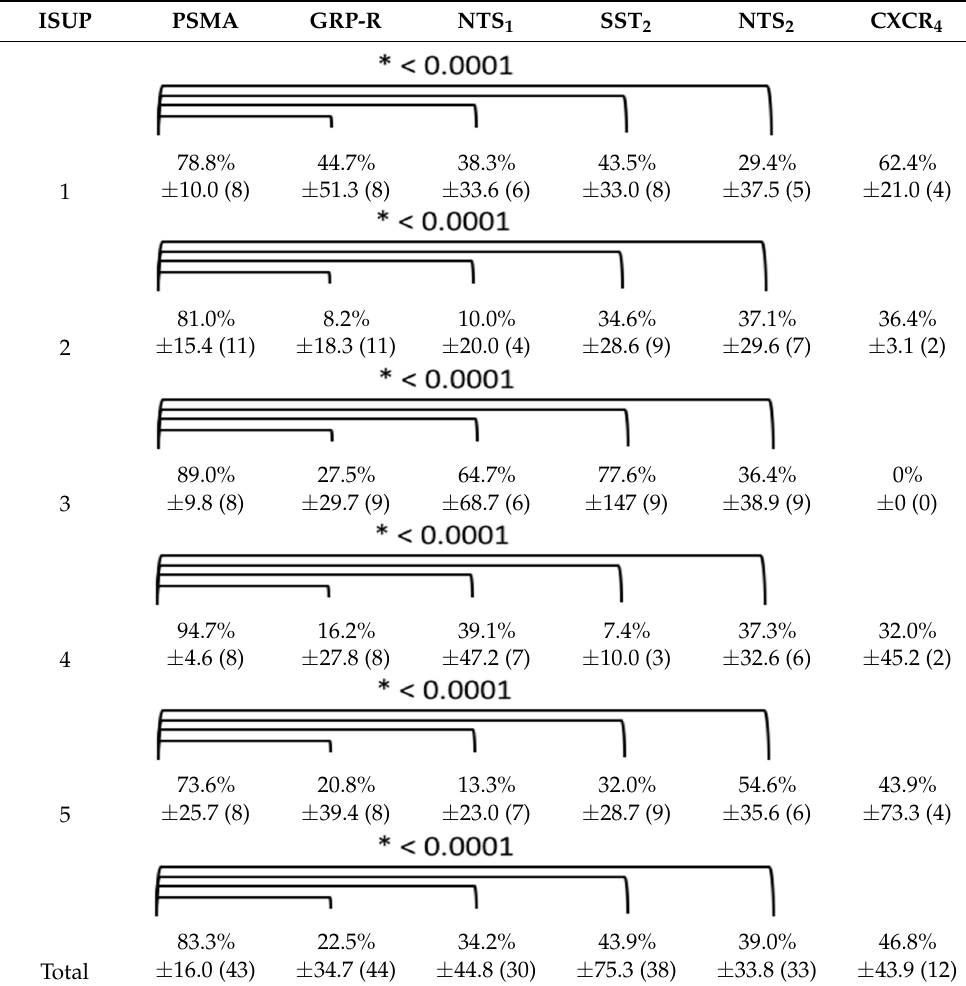
Table 3. ISUP-based strati fi cation and statistical analysis of samples for each target. Speci fi c binding % ± standard deviation (number of samples). Non-parametric one-way ANOVA (Kruskal – Wallis test). p < 0.05 was considered signi fi cant. * stands for signi fi cant di ff erence.